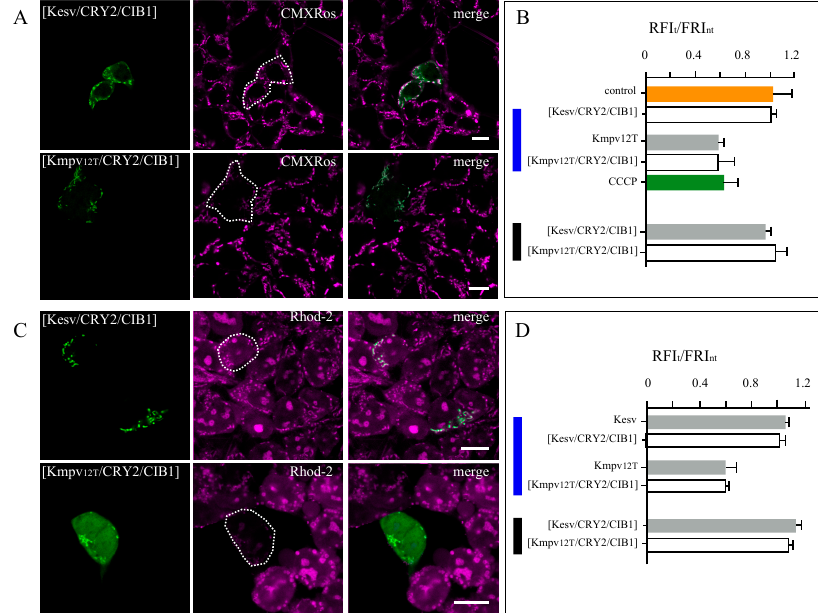
Figure 7. Active Kmpv 12T but not inactive Kesv causes the depolarization of mitochondria and a decrease in organelle Ca 2+ . Fluorescent images of HEK293 cells transfected with GFP-tagged [ Kesv/CRY2/CIB1 ] ( A ) or [ Kmpv 12T /CRY2/CIB1 ] ( C ) (green, 1st column) and stained with MitoTracker™ Red CMXRos (purple, 2nd column ( A ), or Rhod-2 AM (2nd column, C ). Overlays of GFP (green) and CMXRos or Rhod-2 signals (purple) are reported in the third column. The contours of GFP-positive cells in CMXRos and Rhod-2 channels are indicated by dashed lines. ( B , D ) Ratios of CMXRos or Rhod-2 signal from GFP-positive cells (RFI t ) divided by the fluorescence of adjacent non-transfected cells (RFI nt ). For reference, the ratio was also obtained in ( B ) from the CMXRos channel measured in untransfetced cells in the presence (green) and absence (orange) of uncoupler carbonyl cyanide m-chlorophenylhydrazone (CCCP). Data from HEK293 cells expressing Kesv or Kmpv 12T in constitutive manner (gray) or under control of light (open bars) with light stimulation (blue bar) or without (black bar). In the former case, cells were incubated for 16 h and illuminated with a single 1-min light pulse of 6 μ mol 4 h prior to imaging (blue bar). In the latter, control experiment cells were incubated for 16 h before imaging (black bars). Data ± SD are means of N ≥ 3 independent experiments with ≥ 200 cells each. Scale bars 10 μ m.